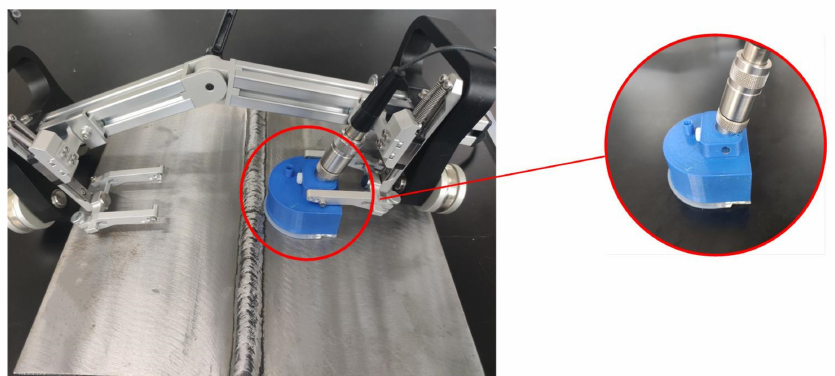
Figure 4. Manufactured PIF transducer and